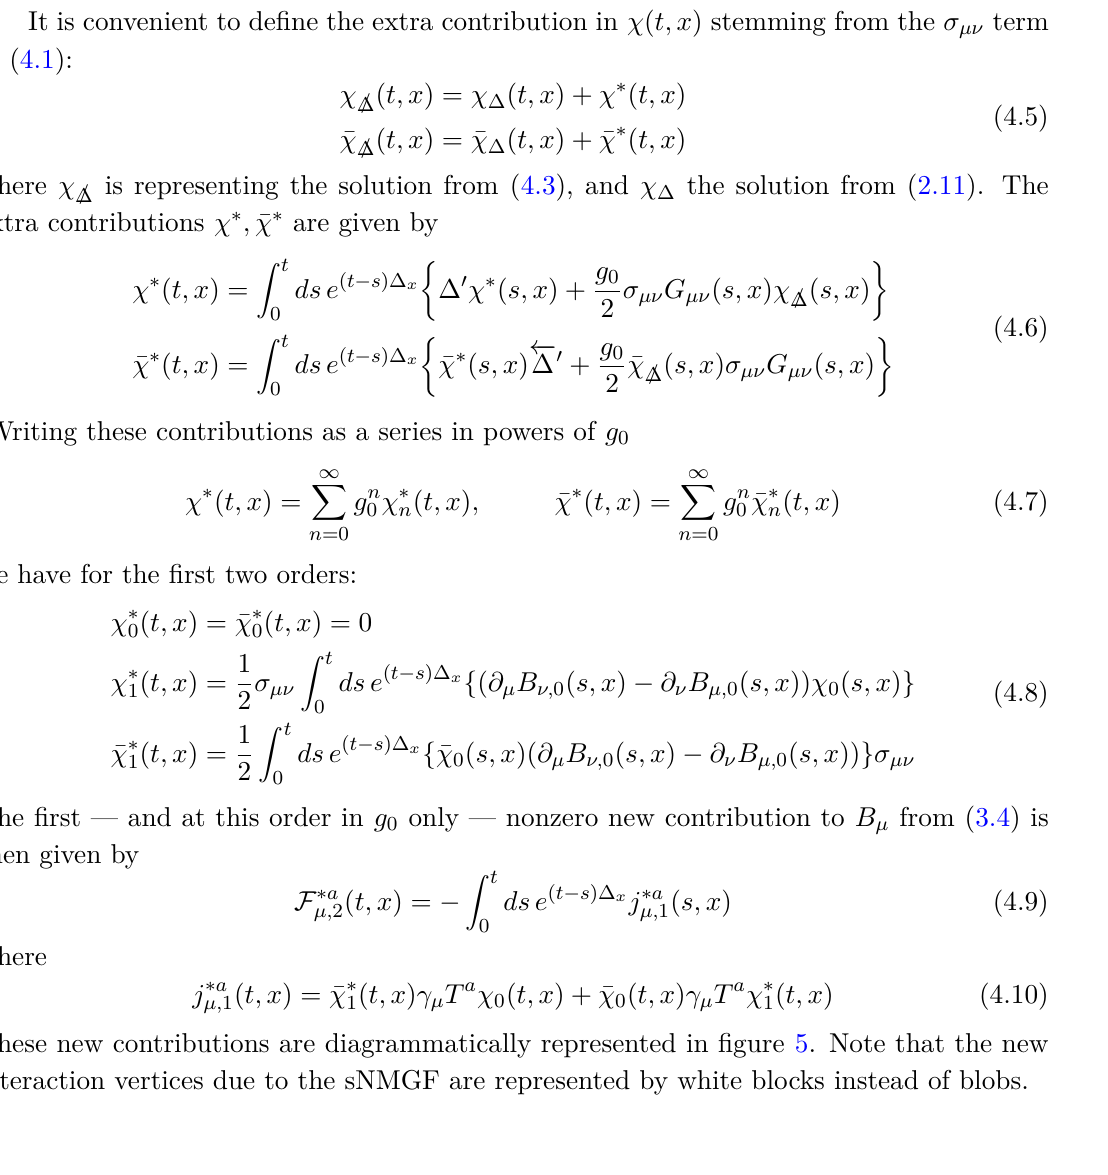
and ¯ χ ∗ from (4.8), while (c) and (d) are 1 1 from µ, 2